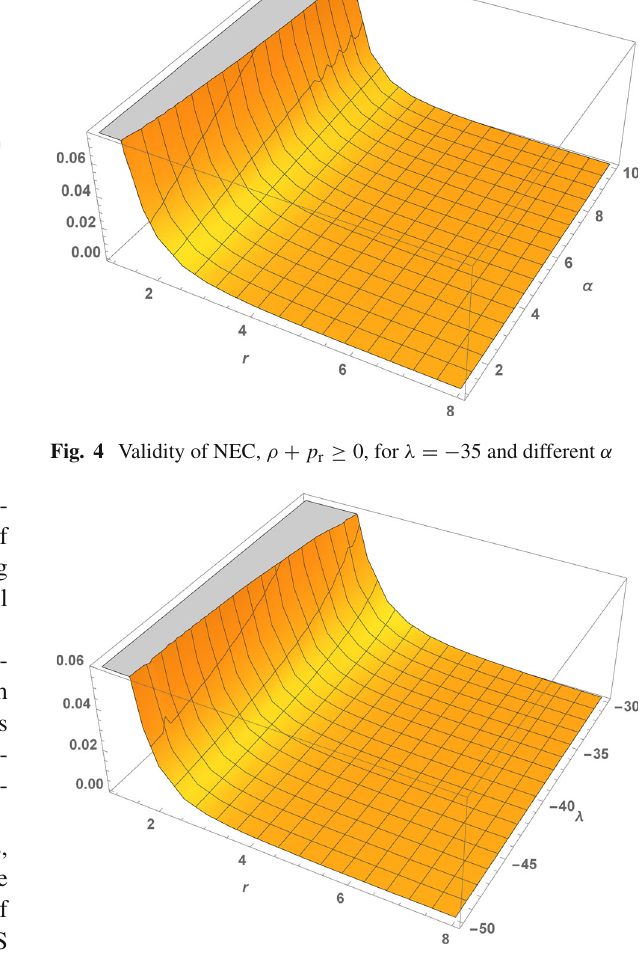
Fig. 5 Validity of NEC, ρ + p r ≥ 0, for α = 5 and different